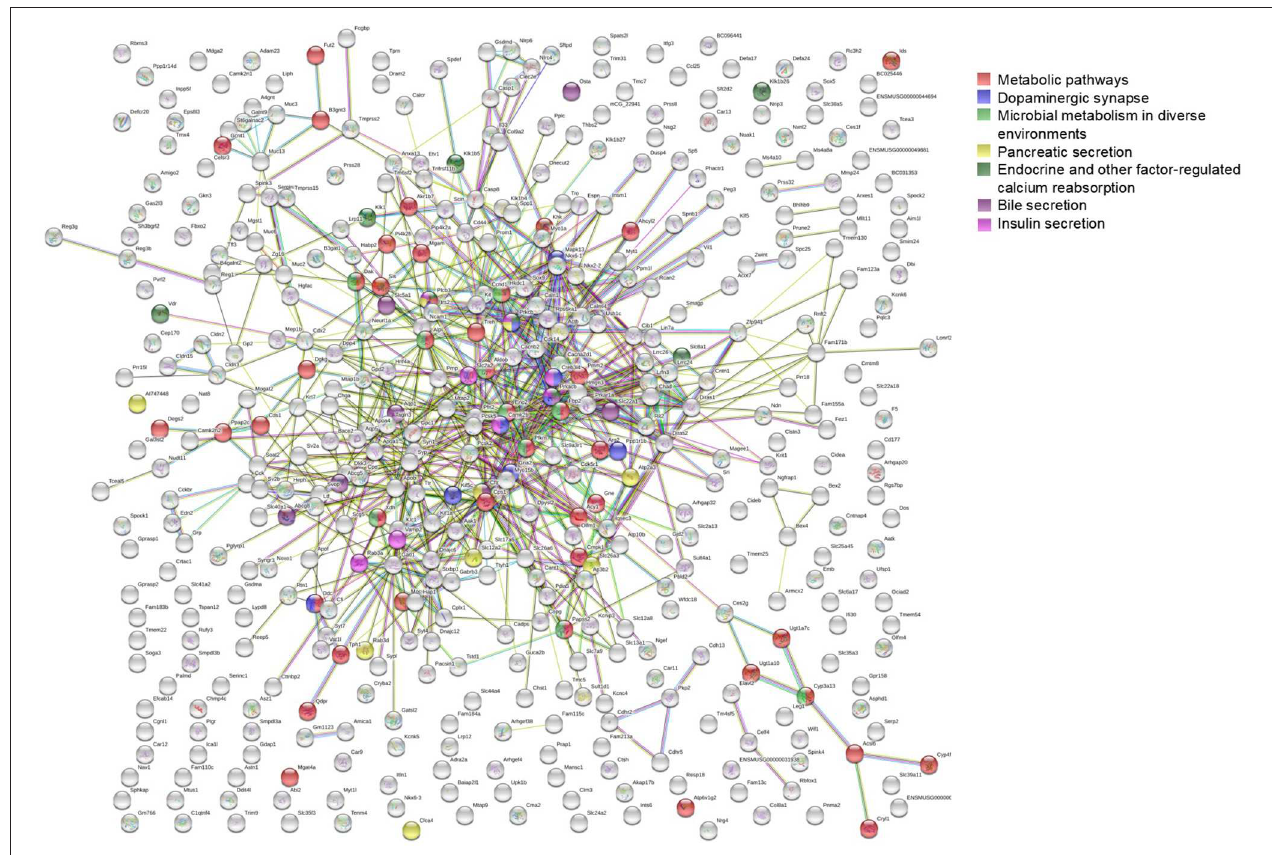
FIGURE 9 | STRING analysis of the array data. Genes differentially expressed between control group and RAD001 treated group ( p < 0.05, fold change > 2) were selected for STRING analysis. Protein-protein interaction was shown. The top 7 pathways which contained the highest gene counts identified by KEGG analysis were labeled on the PPI